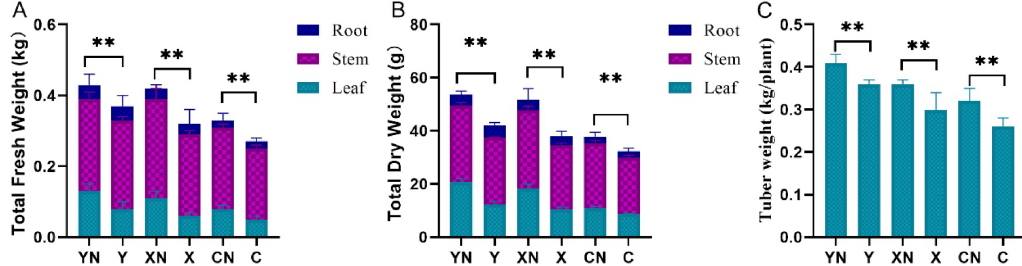
Fig 1. Statistical analysis of the growth performance parameters in response to by nitrogen (N) deficiency. A, B and C shows the total fresh weight, total dry weight and tuber weight, respectively. N = 3, two-way ANOVA test followed by Tukey post-hoc, �� P < 0.01 vs. corresponding variety under N treatment. Y, X and C indicate the cultivar of “Yanshu 4”, “Xiabodi” and “Chunshu 4”, respectively. N means treatment with N containing fertilizer (control). For example, YN and Y means “Yanshu 4” treated with N-containing and N-deficiency fertilizer,